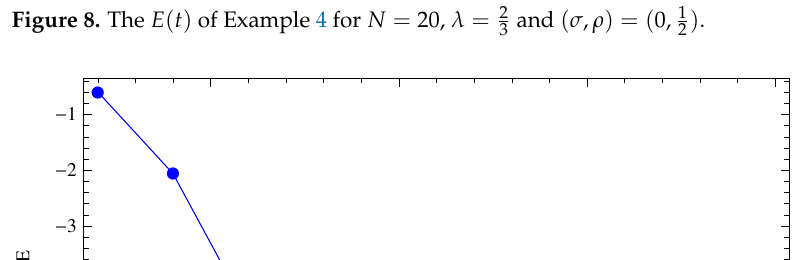
Figure 8. The E ( t ) of Example 4 for N = 20, λ = 2